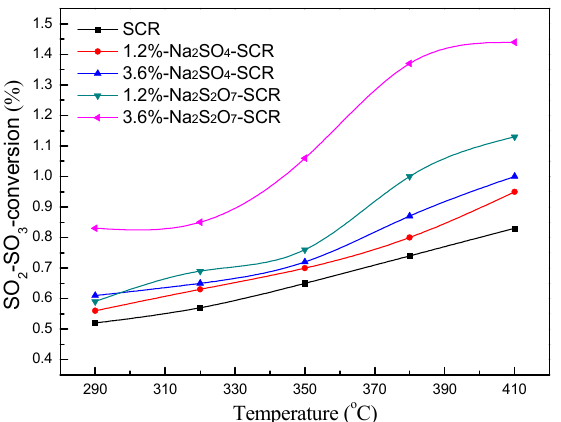
Figure 1. Effect of temperature on SO 3 generation. Reaction conditions: 1800 ppm SO 2 , 5% O 2 , 500 ppm NO, 500 ppm NH 3 , 2% H 2 O, total flow gas 1.5 L/min, and gas hourly space velocity (GHSV) = 45,000 h − 1 .